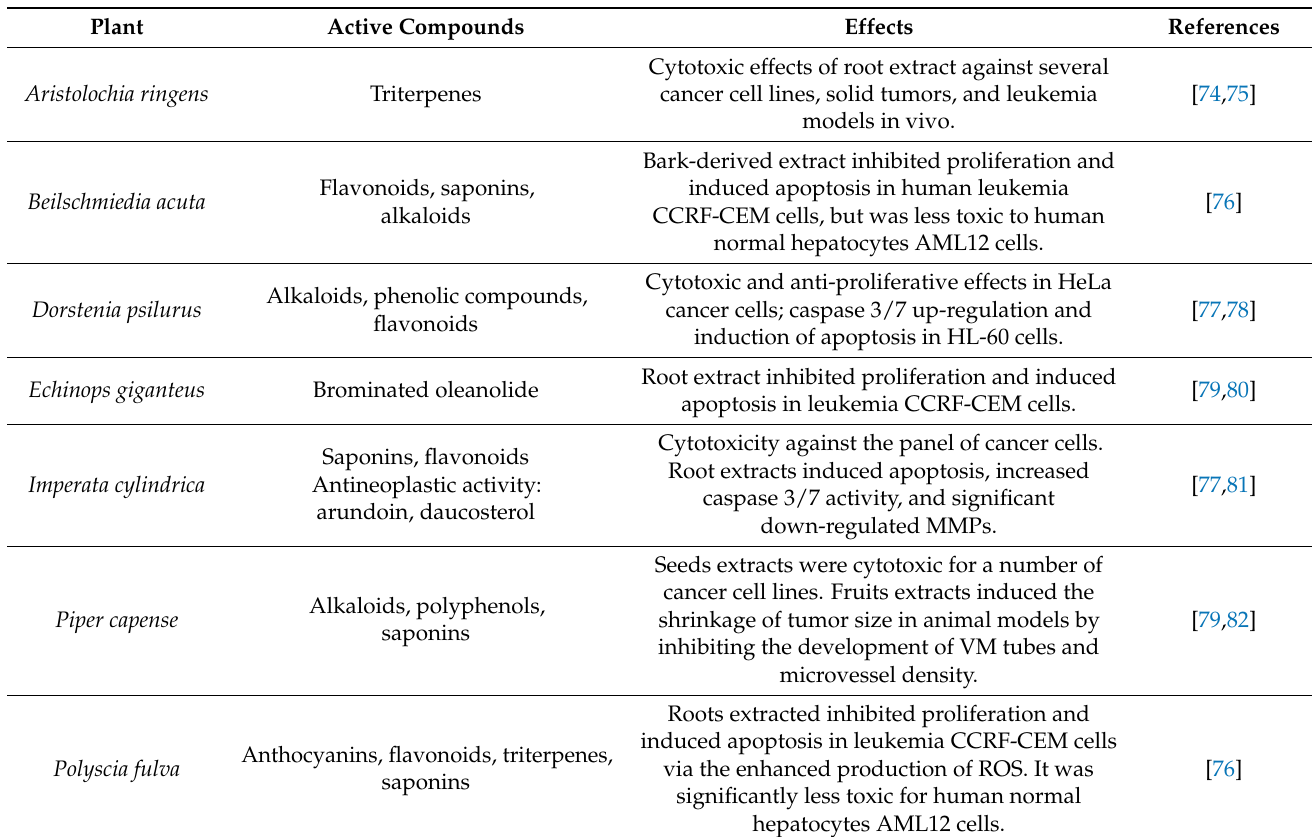
Table 1. Some African plants and their compounds with anti-neoplastic